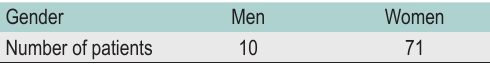
TABLE 1. Presentation of prevalence of the billateral primary gonarthrosis in both gender in the clinics D.Z. “Novi Grad”